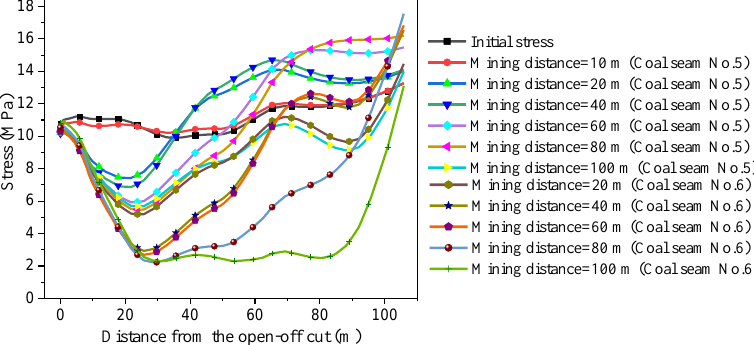
Figure 5. The stress state in the protected seam after the mining of protective seams.